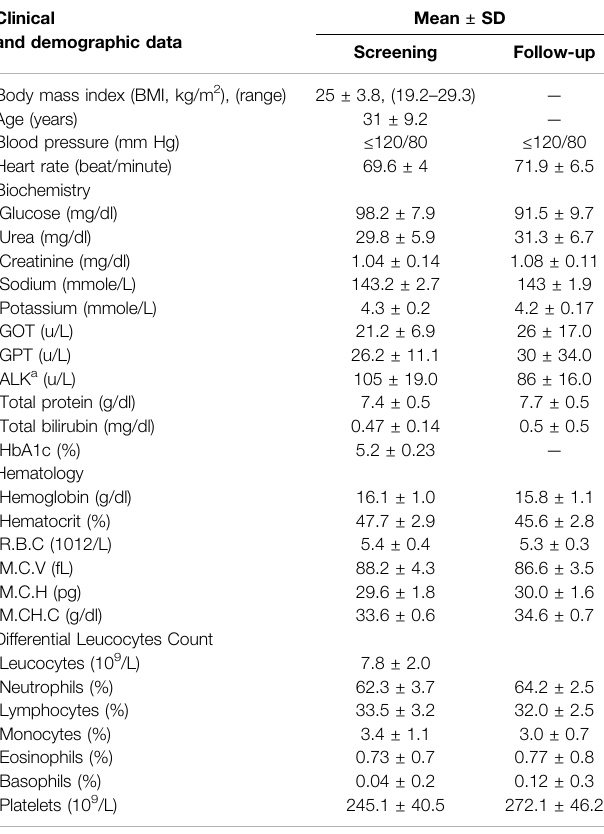
TABLE 1 | Clinical and demographic data of recruited subjects ( n (cid:2) 26 male) during screening and follow-up periods. Clinical and demographic